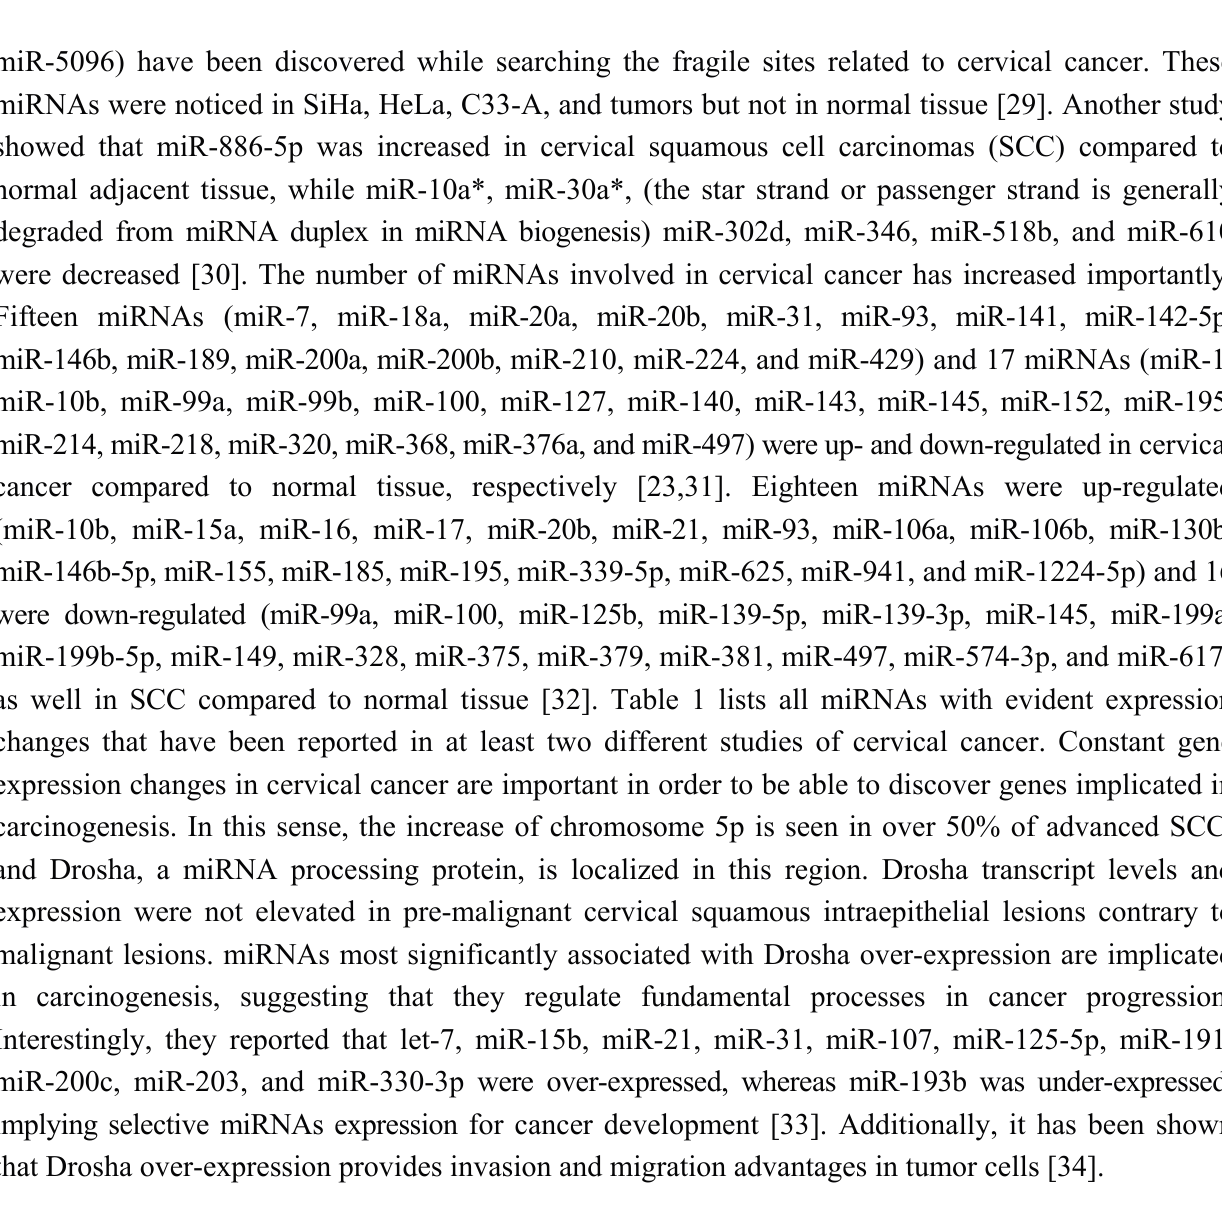
Table 1. miRNAs with constant change in at least two experimental studies. Star strand (miRNA*) or passenger strand is generally degraded from miRNA duplex in miRNA